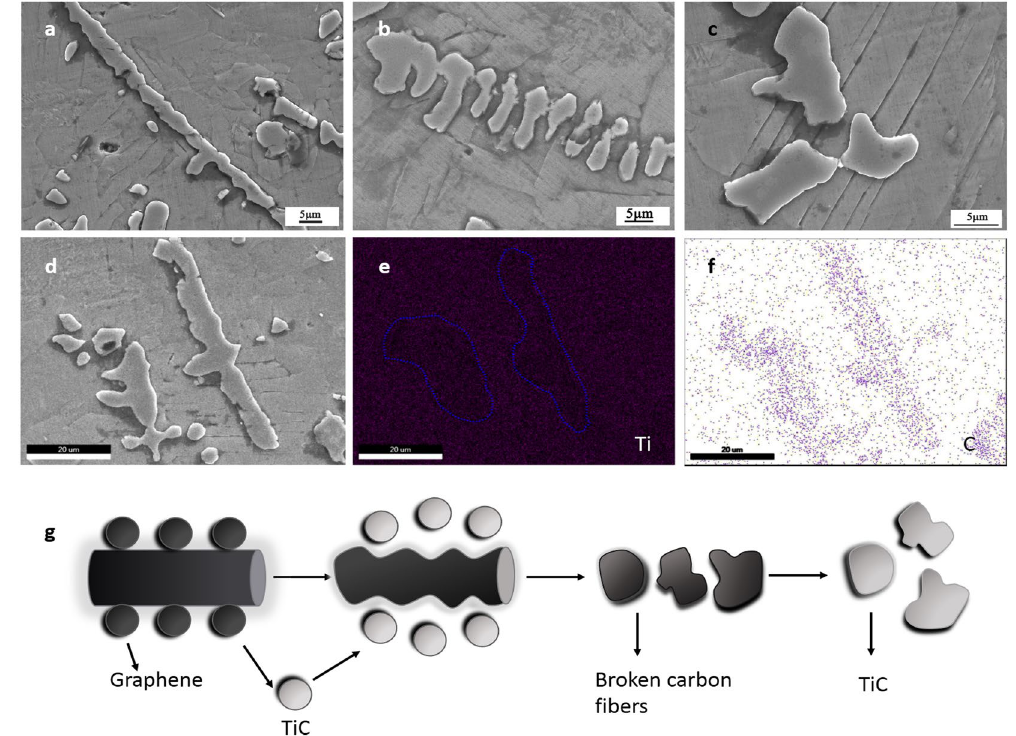
Figure 3. SEM images and map scan of CFGRTAC remelted twice. ( a ) Carbon fibers distribution in the TiAl matrix ( b ) a carbon fiber under reaction ( c ) reaction product TiC after the reaction of carbon fibers ( d ) complete carbon fibers ( e , f ) refer to the map scanning in Fig. 4d of Ti and C, respectively. ( g ) The evolution process model of carbon fibers in the TiAl